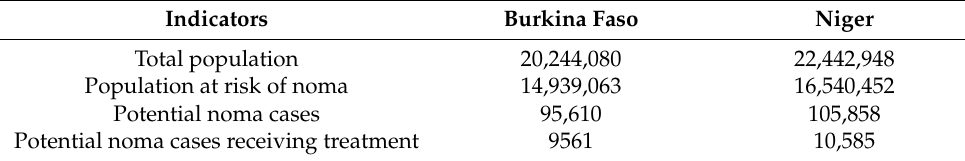
Table 2. Prevalence of Noma cases in Burkina Faso and Niger in 2018.